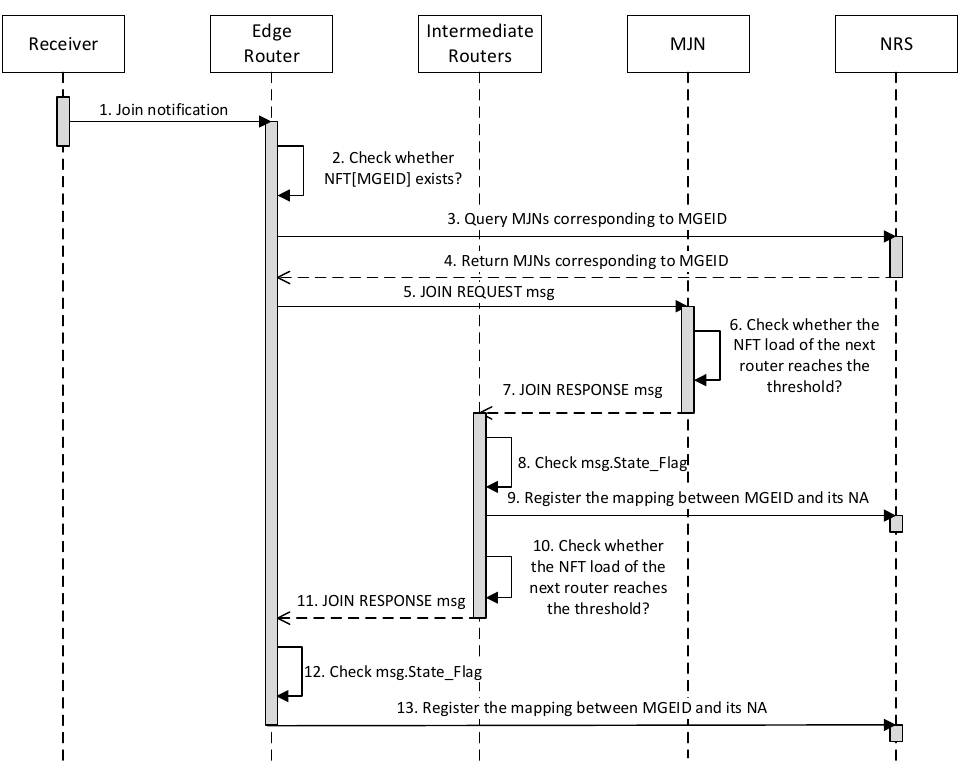
Figure 2. The message sequence chart diagram of joining a group.